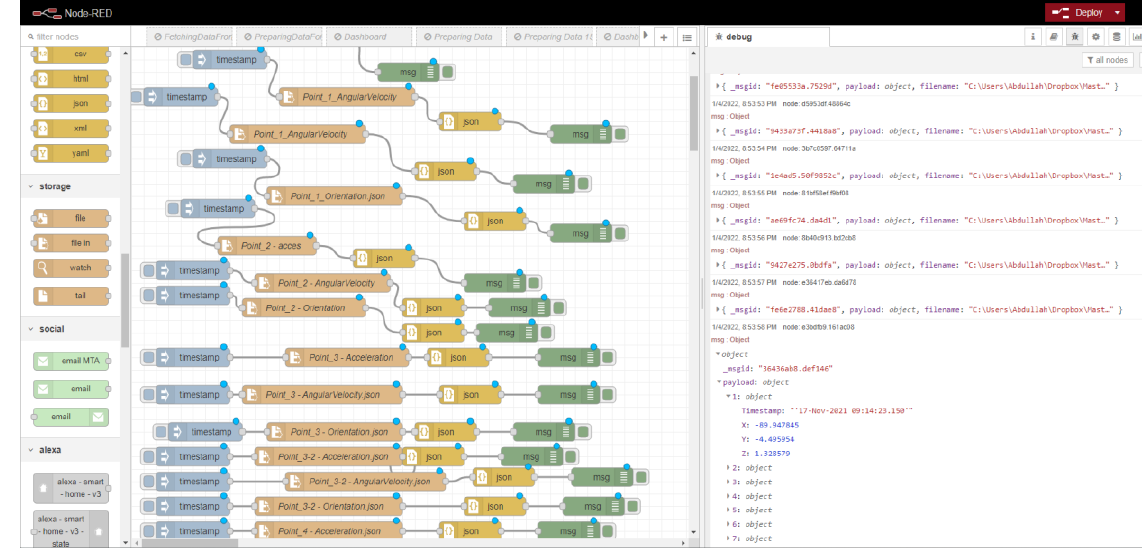
Figure 65. Overview of connected inertial measurement unit sensors using Node-RED.